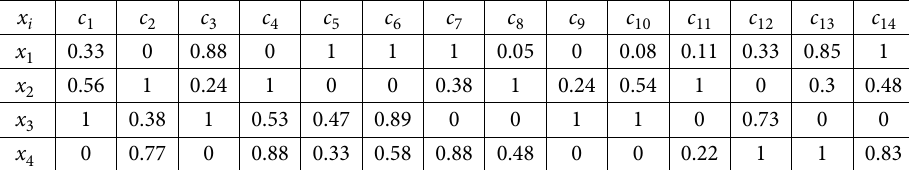
Table 5. The normalized evaluation matrix